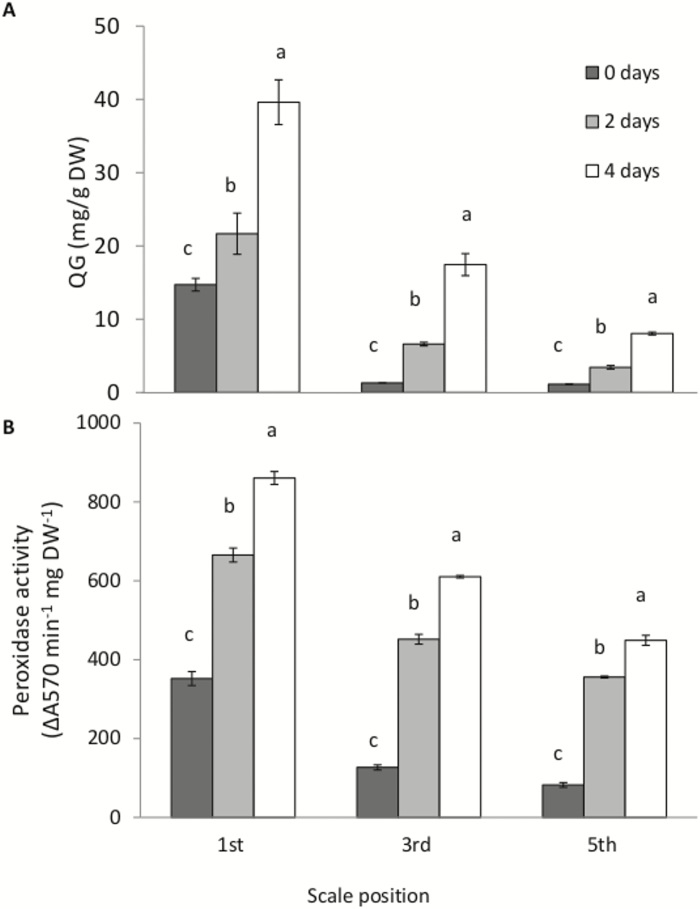
Quercetin glucoside (QG) content and peroxidase activity are higher in the outer onion scale following heat treatment. (A) QG contents and (B) peroxidase activity were measured in the 1st, 3rd, and 5th scales following 0, 2, and 4 d of heat treatment at 33 °C, 98% RH. Data are means (±SE) for five repeated experiments. Different letters indicate significant differences between treatment times at each scale position according to ANOVA test (P < 0.05).